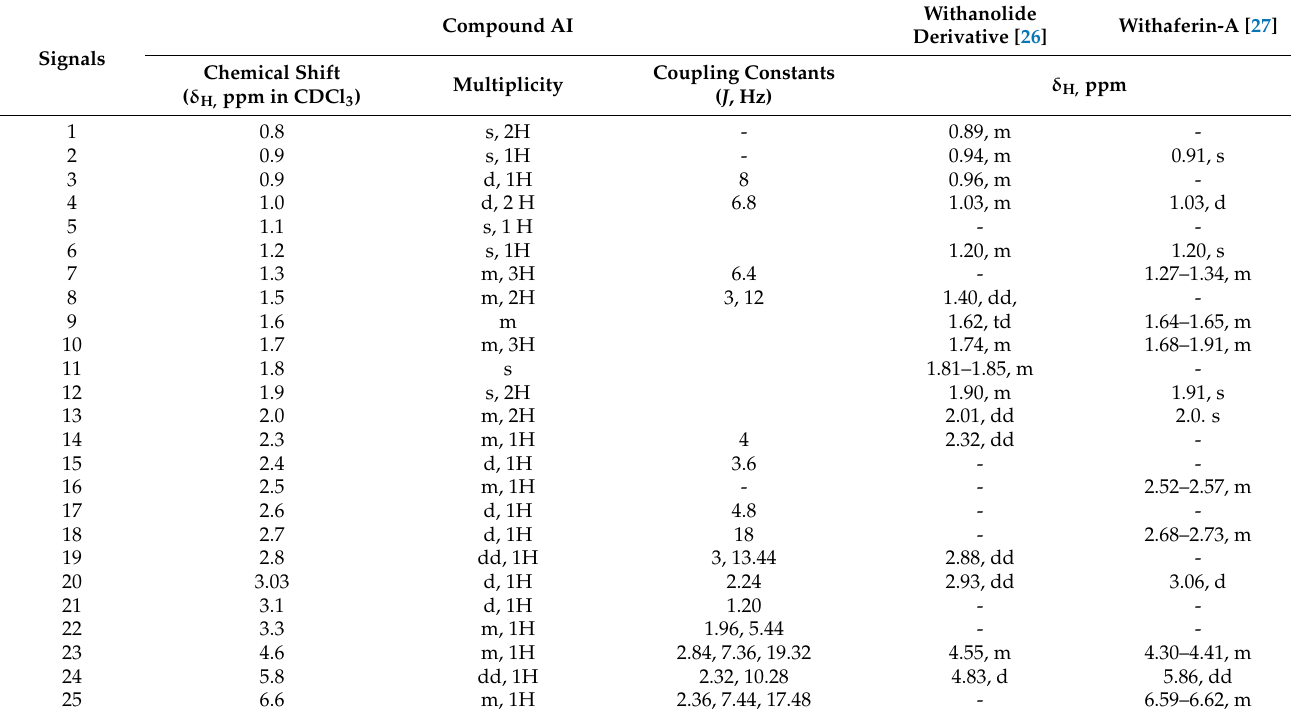
Withanolide Withaferin-A [27] Derivative [26]